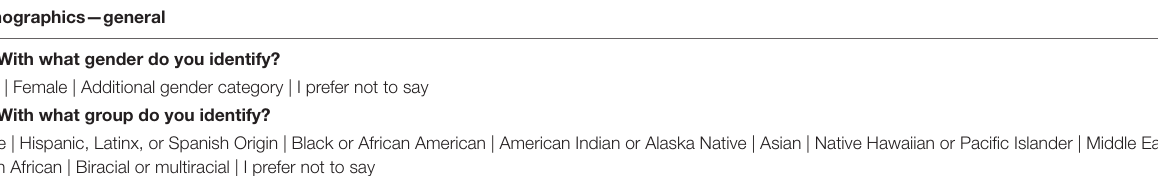
TABLE 1 | Undergraduate nature engagement